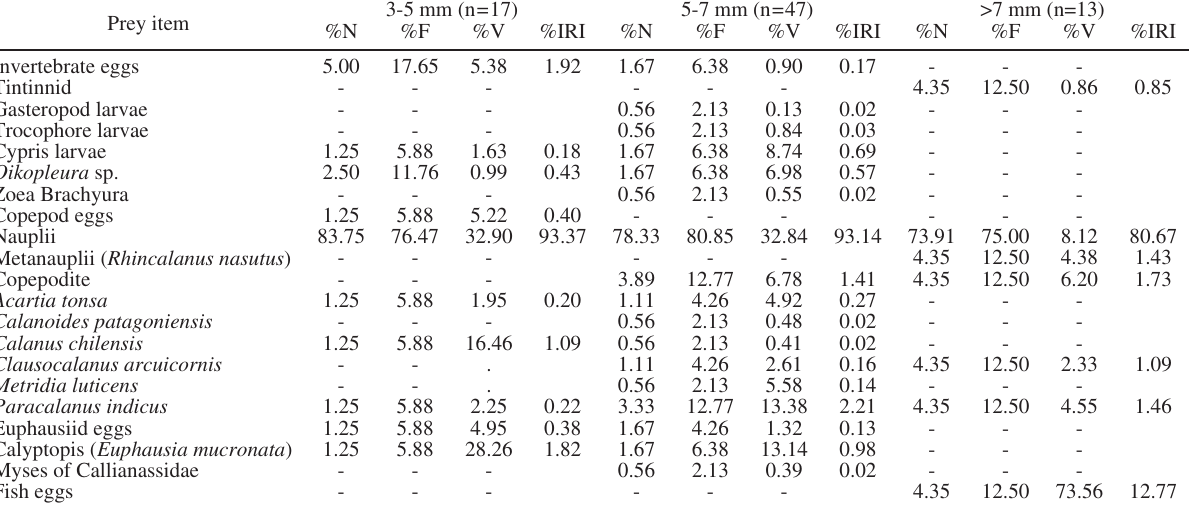
Table 2. – Prey composition of Pacific sandperch, P. jugularis , larvae off central Chile. %N corresponds to the percent of the total number of prey items, %F to the percent frequency of the occurrence of a diet among larvae with food in their guts, and %V to the percent of the total volume of prey items. %IRI corresponds to the index of relative importance as a percentage.